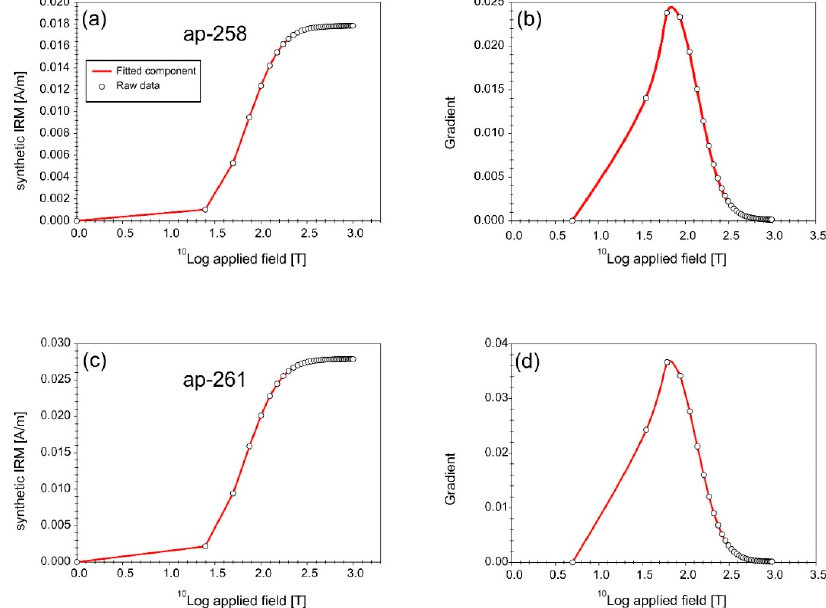
Figure 7. Isothermal remanent magnetization (IRM) decomposition plots for the representative particulate matter samples show linear acquisition plots (LAP) ( a , c ) and gradient acquisition plots (GAP) ( b , d ).